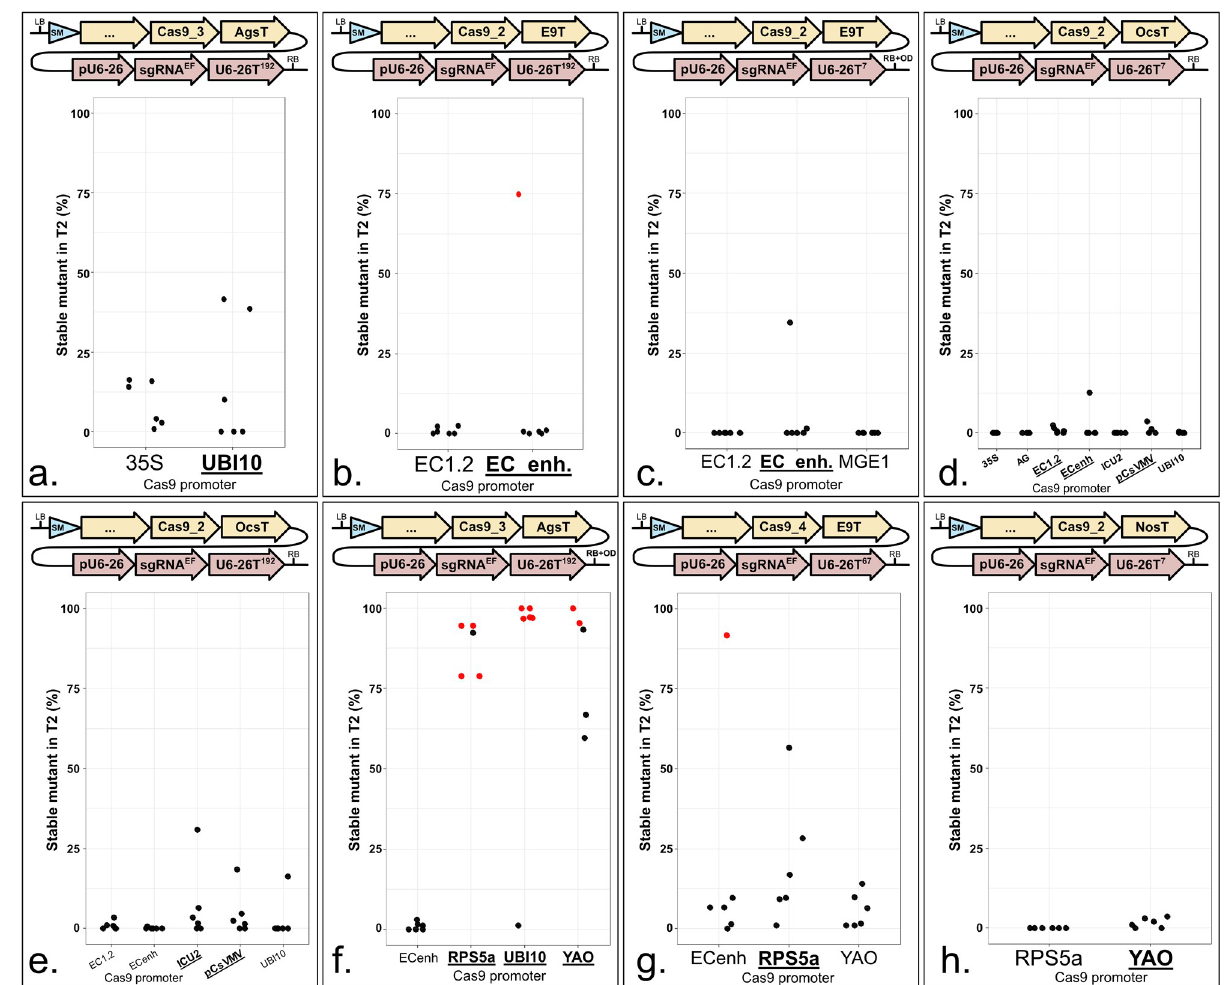
Fig 3. UBI10 , YAO and RPS5a promoter-regulated Cas9 expression enhances mutation rates. a. to h. Each panel represents a promoter comparison in the same T-DNA context. Promoters can be compared within each panel, but not from one panel to another. The modules were assembled into pICSL4723 (RB+OD, with an overdrive ) or pAGM4723 (RB, without an overdrive ) and transformed into Col-0 via Agrobacterium tumefaciens strain GV3101. LB: Left Border. SM: Selectable Marker ( Glufosinate resistance gene). 35S: 426 bp of the 35S promoter from Cauliflower Mosaic Virus . UBI10: 1327 bp of the At4g05320 promoter. EC1.2: 1014 bp of the At2g21740 promoter. EC_enh.: 752 bp of the At2g21740 promoter fused to 548 bp of the At1g76750 promoter. MGE1: 1554 bp of the At5g55200 promoter. AG: 3101 bp of the At4g18960 promoter. ICU2: 625 bp of the At5g67100 promoter. CsVMV: 517 bp of a promoter from Cassava Vein Mosaic virus. RPS5a: 1688 bp of the At3g11940 promoter. YAO: 596 bp of the At4g05410 promoter. Cas9_1: Mali et al ., 2013 [3]. Cas9_2: Fauser et al ., 2014 [13]. Cas9_3: Li et al ., 2013 [25]. Cas9_4: Le Cong et al ., 2013 [10]. E9T: 631 bp of the Pisum sativum rbcS E9 terminator. OcsT: 714 bp of the Agrobacterium tumefaciens octopine synthase terminator. AgsT: 410 bp of the Agrobacterium tumefaciens agropine synthase terminator. NosT: 267 bp of the Agrobacterium tumefaciens nopaline synthase terminator. pU6-26: 205 bp of the At3g13855 promoter. sgRNA EF : “extension-flip” sgRNA. U6-26T: 7, 67 or 192 bp of the At3g13855 terminator. RB: Right Border. d. Five lines were tested for UBI10 and ICU2 and four lines for AG instead of six. F. Five lines were tested for YAO and RPS5a instead of six. The sgRNA targets ADH1 . CRISPR activity measured in % of homozygous or biallelic stable mutants in the second generation after transformation (T2). Each dot represents an independent T2 family. Red dot: All the T2 lines from this family carry the same mutation, indicating a mutation more likely inherited from the T1 parent rather than being de novo from the T2 line. Bold and underlined: Most active construct(s) for each panel.